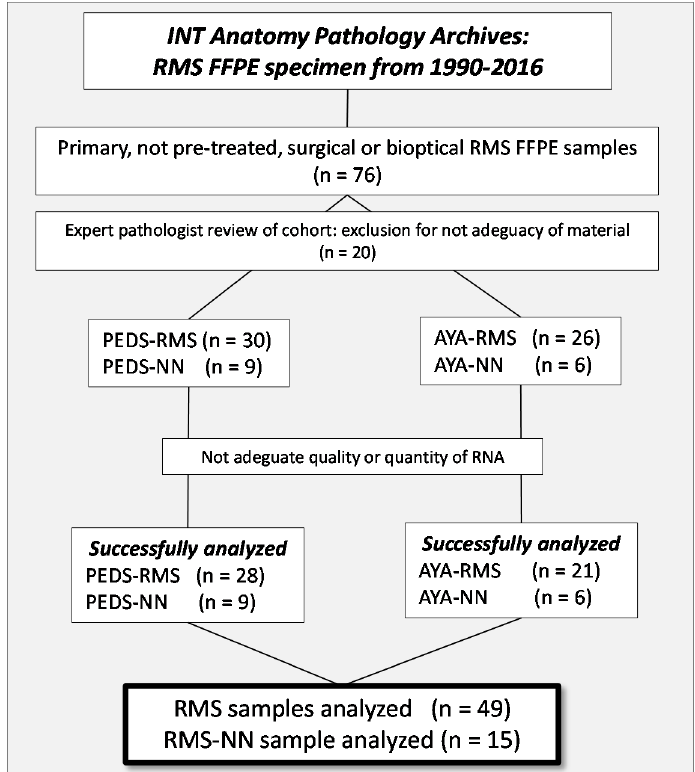
Figure 6. Consort Diagram. A flow diagram of the progress through the phases of recruitment and selection of the studied cohort of PEDS- and AYA RMS.